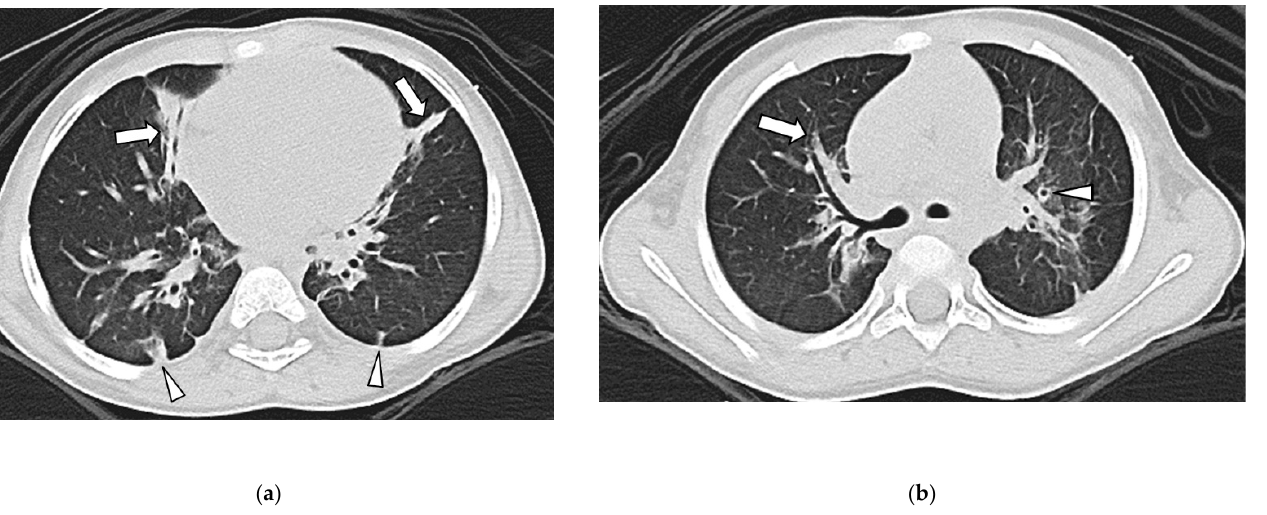
Figure 3. Three-year-old girl with prematurity-related lung disease. ( a ): Axial lung window CT image shows triangular/linear plaque-like opacity (arrows) in both lungs. Pleural based atelectasis (arrowheads) is also seen. However, no pleural thickening is noted. ( b ): Axial lung window CT image demonstrates bronchial wall thickening (arrowhead) and bronchiectasis (arrow).